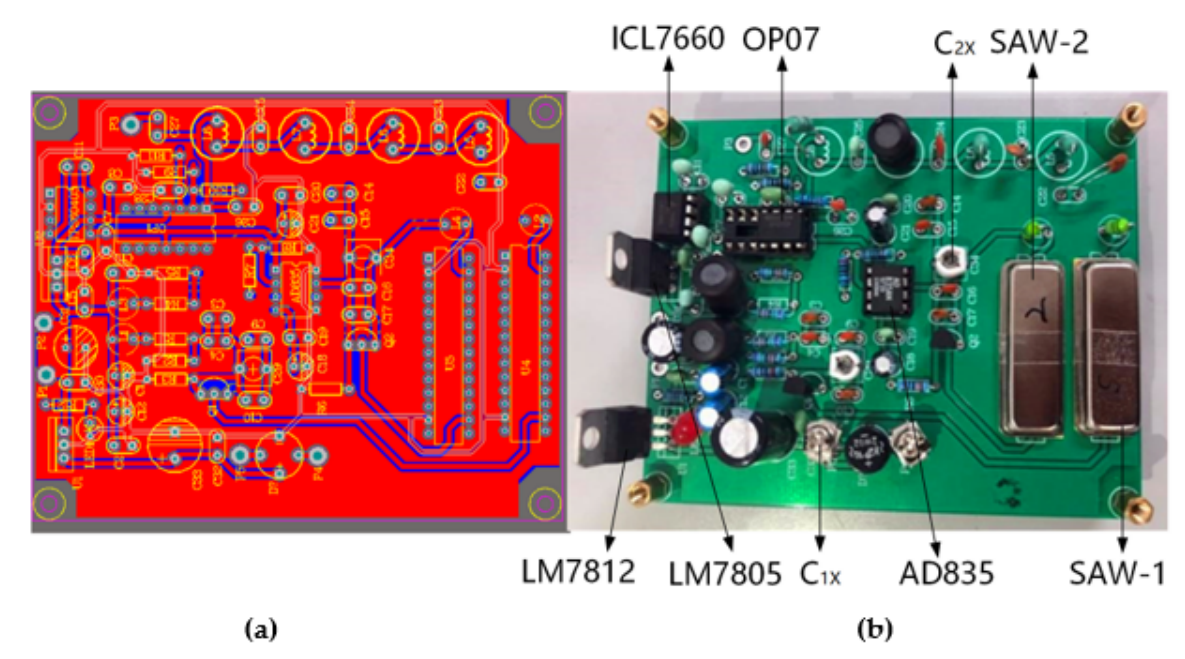
Figure 5. Diagram of the dual differential surface acoustic wave oscillator system. ( a ) The design of PCB. ( b ) The Circuit board.